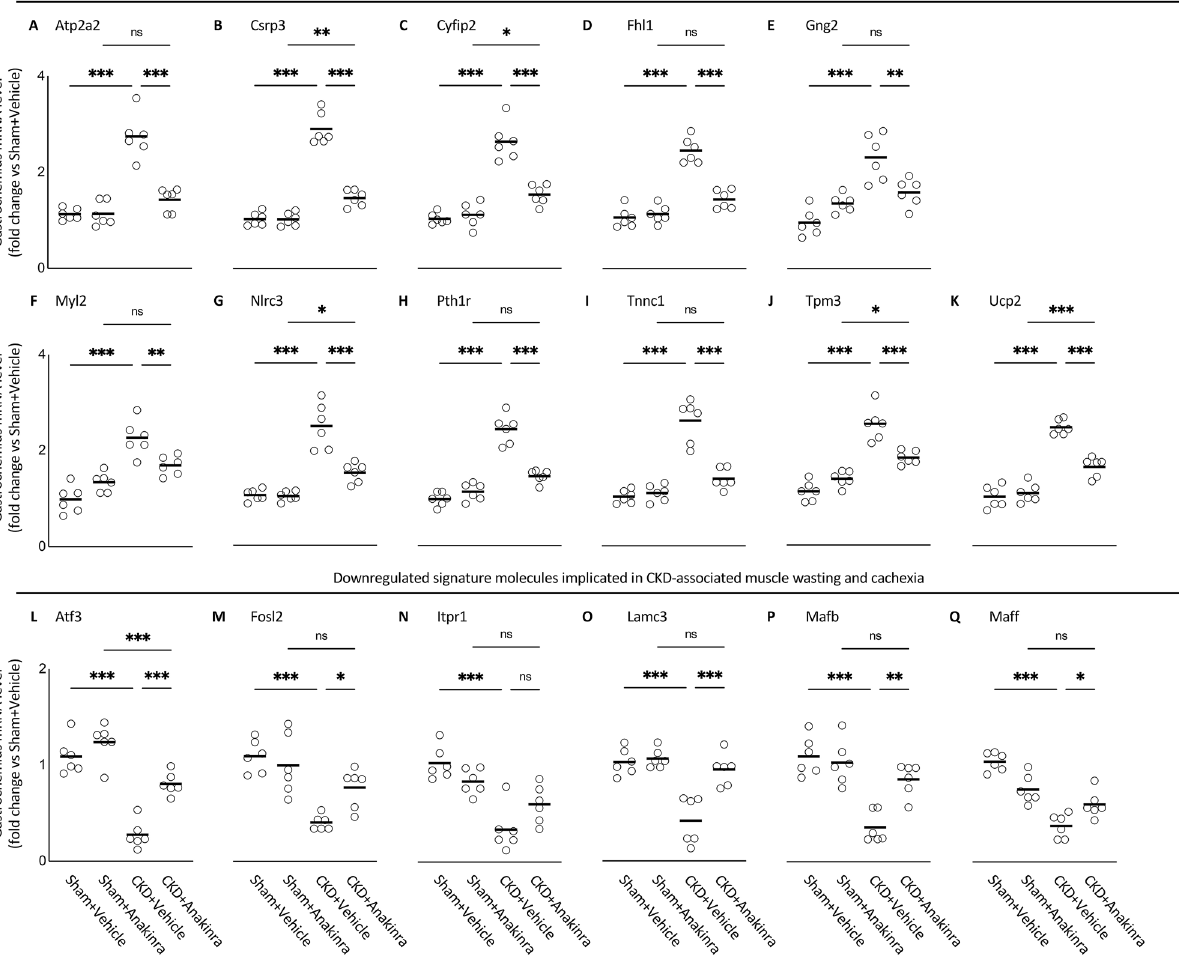
Figure 8. Anakinra attenuates expression of the top 17 differentiated expression gastrocnemius muscle genes in CKD mice. Gastrocnemius muscle expression of interested genes in mice was measured by qPCR. Transcriptional expression of upregulated signature molecules implicated in CKD-associated muscle wasting and cachexia (Atp2a2, Csrp3, Cyfip2, Fhl1, Gng2, Myl2, Nlrc3, Pth1r, Tncc1, Tpm3 and Ucp2) ( A – K ) and downregulated signature molecules implicated in CKD-associated muscle wasting and cachexia (Atf3, Fosl2, Itpr1, Lamc3, Mafb and Maff) ( L – Q ) were expressed in arbitrary units, with one unit being the mean level in WT/Sham + Vehicle mice. Results of WT/CKD + Vehicle were compared to WT/Sham + Vehicle and WT/CKD + Anakinra were compared to WT/Sham + Anakinra, respectively. In addition, results of WT/ CKD + Anakinra were also compared to WT/CKD + Vehicle. * p < 0.05, ** p < 0.01, *** p <